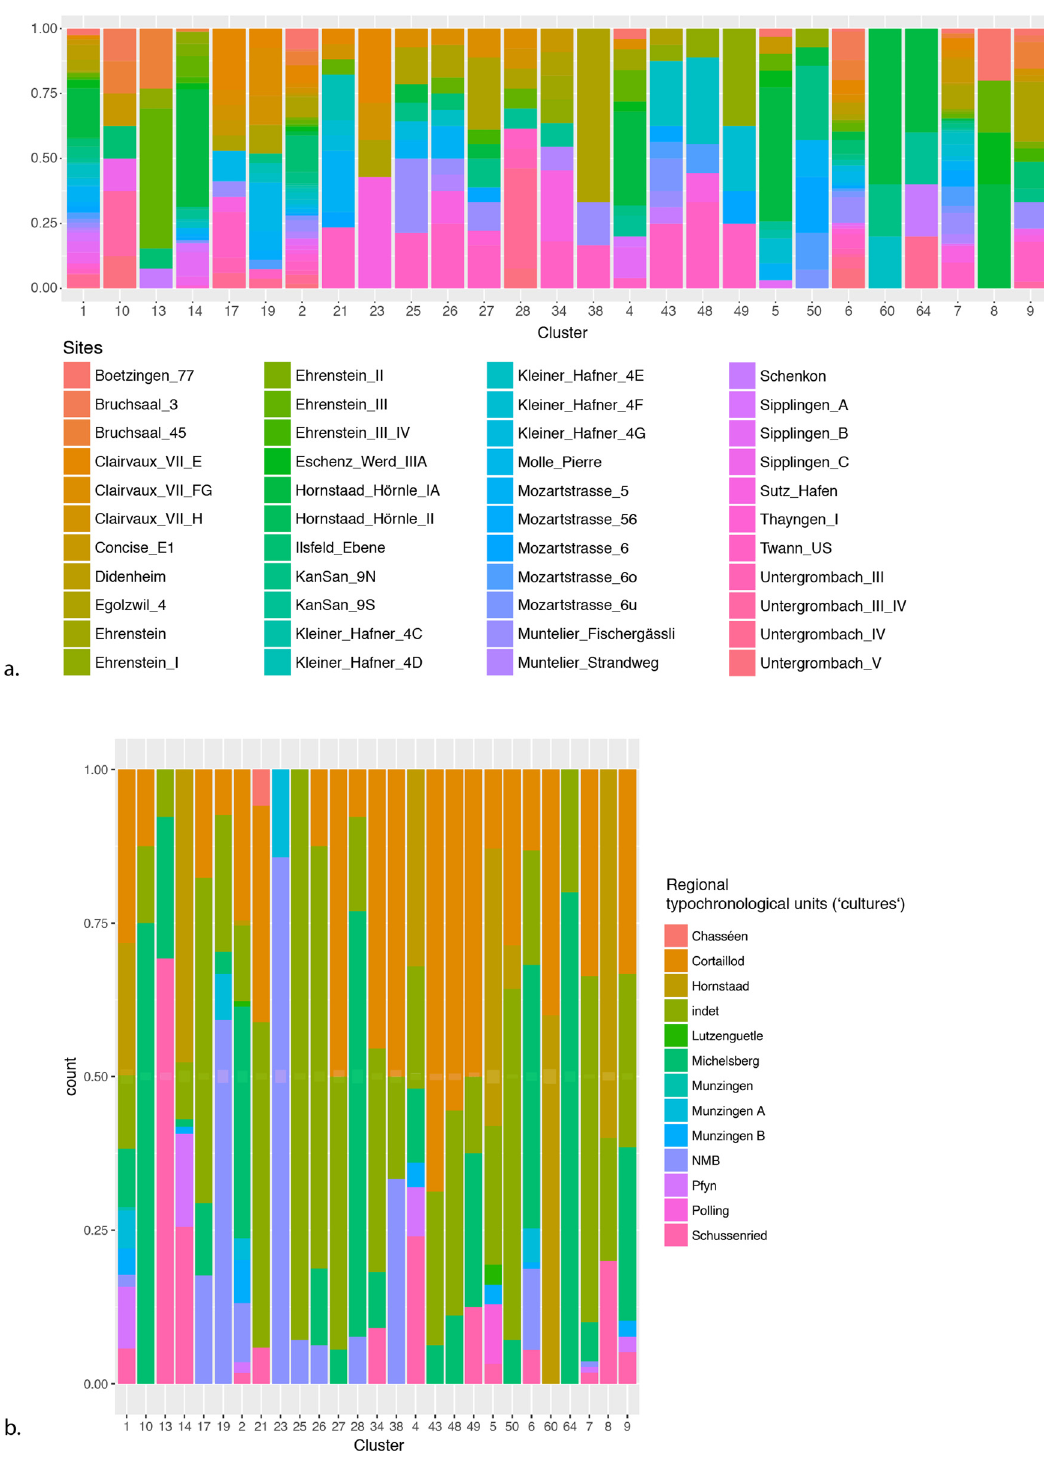
Figure 13: Result of the unsupervised classi fi cation regarding temporal and spatial attribution of the potter, ( a ) proportions ( relative frequency ) of sites ( pottery assemblages of feature units ) per cluster of the fi rst hierarchy level and ( b ) of the typo - chronological ceramic groups per cluster on the fi rst hierarchy level ( fi gure: M. Hinz )